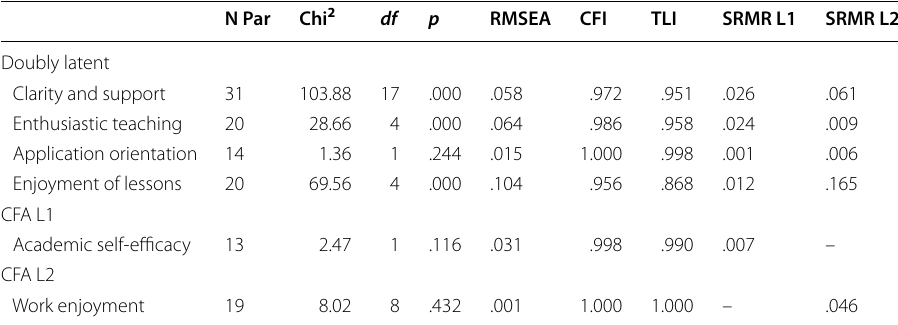
Table 2 Model fit indices of doubly latent models (for aggregate constructs) and confirma‑ tory factor analyses (for non‑aggregate